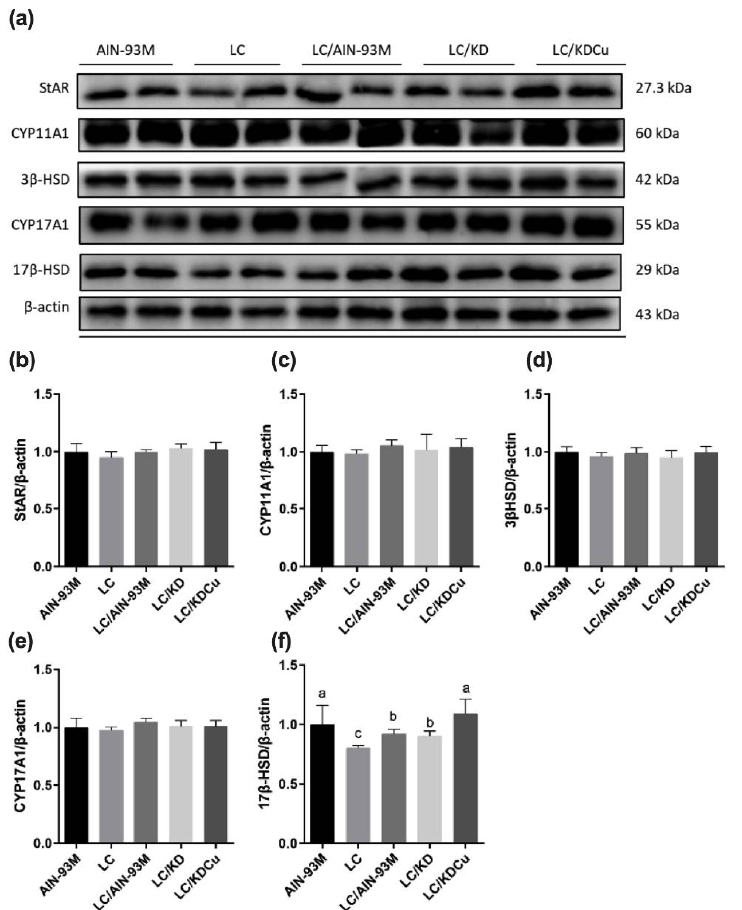
Figure 6. Effects of the low carbohydrate diet and curcumin on testosterone biosynthesis regulators ( a ) protein expressions in each group, ( b ) StAR, ( c ) CYP11A1, ( d ) 3 β -HSD, ( e ) CYP17A1, ( f ) 17 β -HSD relative density analysis of the protein bands in male mice. Data are expressed as means ± SD. n = 6–9 per group. Bars (a, b, c) with different letters indicate that values are significantly different. (One-way ANOVA, Duncan’s test, p < 0.05). AIN-93M: AIN-93M diet; LC: low carbohydrate diet; LC/AIN-93M: low carbohydrate diet changed to AIN-93M diet; LC/KD: low carbohydrate diet changed to ketogenic diet; LC/KDCu: low carbohydrate diet changed to ketogenic diet and